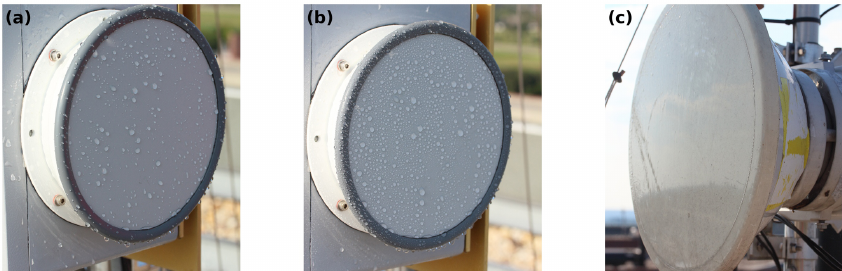
Figure 14. Photographs of the receiving antenna covers, during the wet antenna experiment, taken just after the antennas were sprayed. Panels (a) and (b) are two instances of the RAL 38GHz cover. Panel (c) is the Nokia Flexihopper cover.